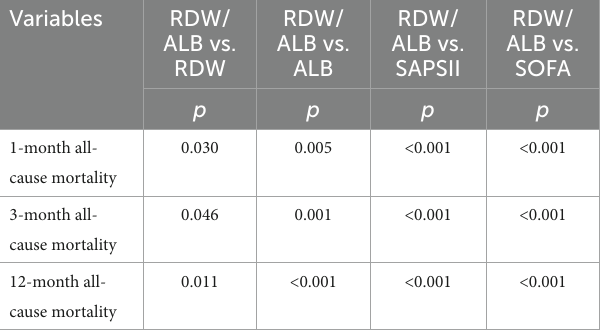
TABLE 5 Comparison of differences in C-index of RDW/ALB, RDW, ALB, SAPSII, and SOFA. Variables